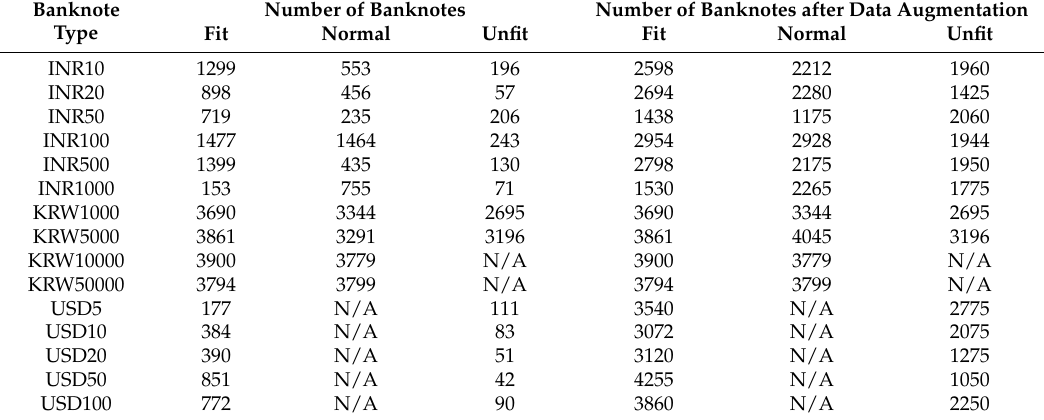
Figure 9. Examples of USD banknote images: ( a ) fit and ( b ) unfit banknotes. Images on the left and right of each figure are the VR and IRT images of the input banknote, respectively. Table 7. Number of input banknotes in the experimental multinational banknote fitness dataset.